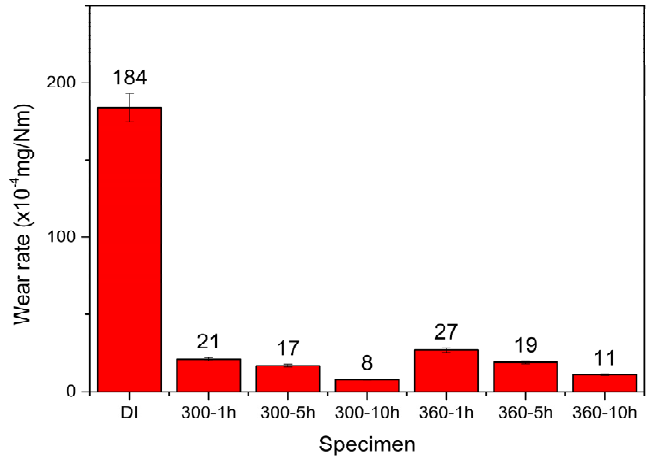
Figure 8. Comparison of wear rates among the specimens after dry wear testing.